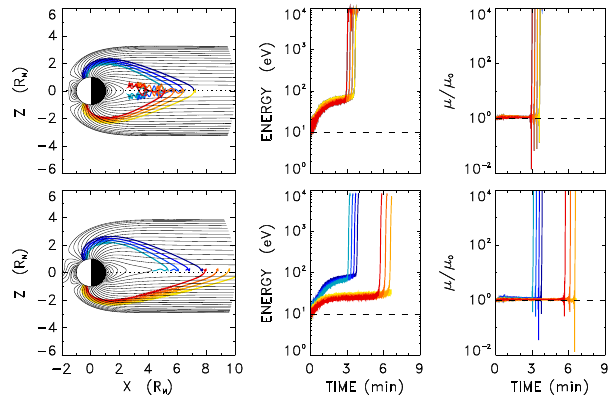
Fig. 5. Identical to Fig. 4 but for